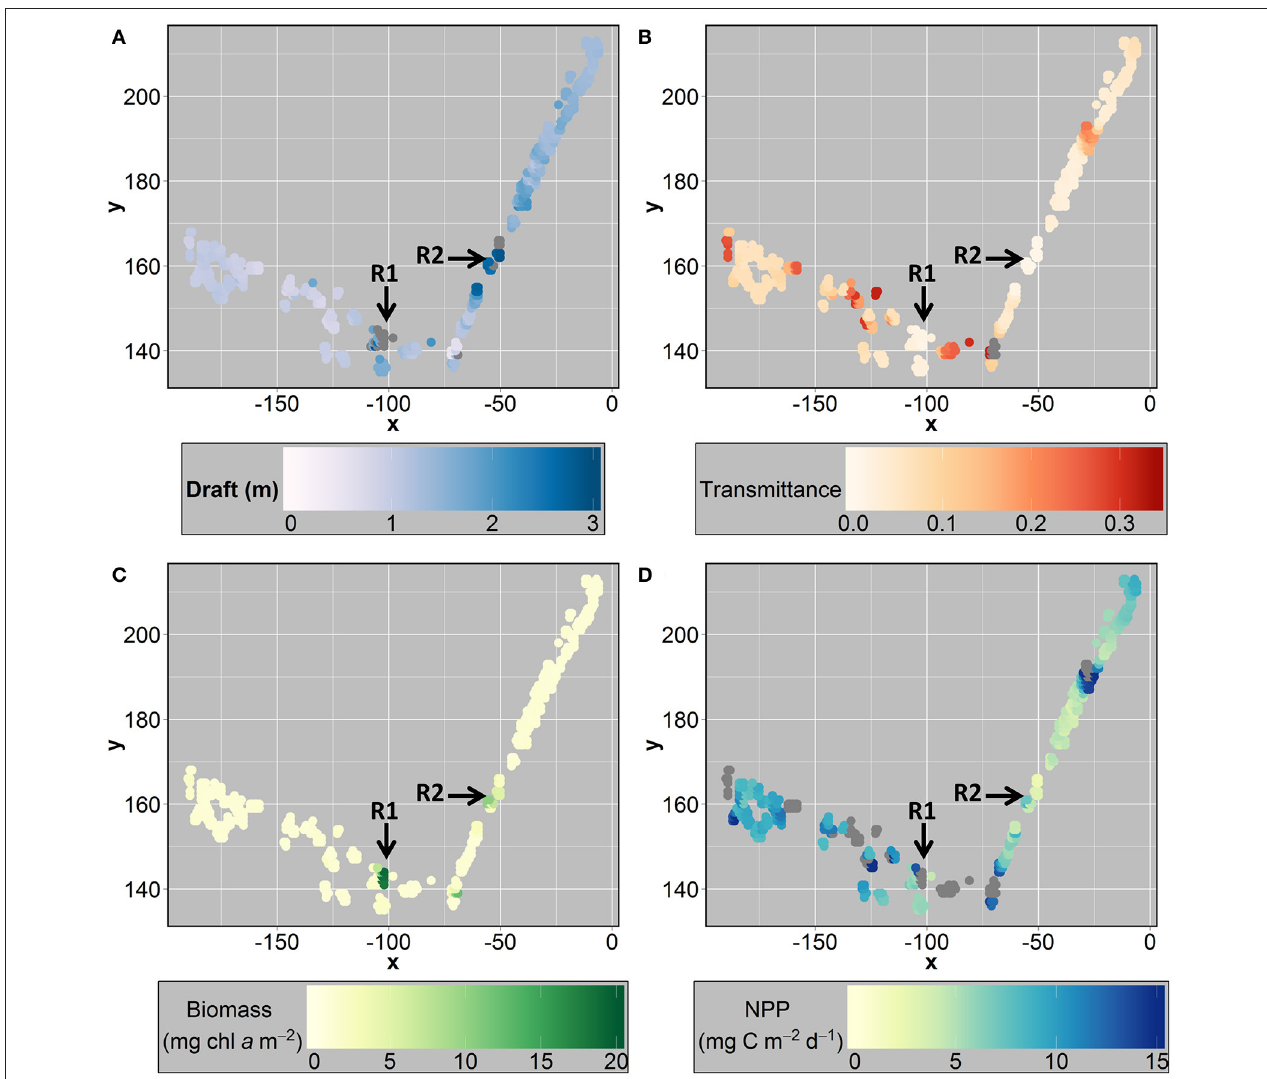
FIGURE 6 | Gridded x-y (meters) map of the remotely operated vehicle (ROV) station 224, showing: (A) draft (m); (B) transmittance; (C) chlorophyll a biomass (mg m − 2 ) derived from ROV spectral radiation measurements; and (D) net primary production-NPP (mg C m − 2 s − 1 ) derived from ROV measurements. R1 and R2 depict ridge 1 and ridge 2, respectively. Gray circles represent values greater than the scale maximum